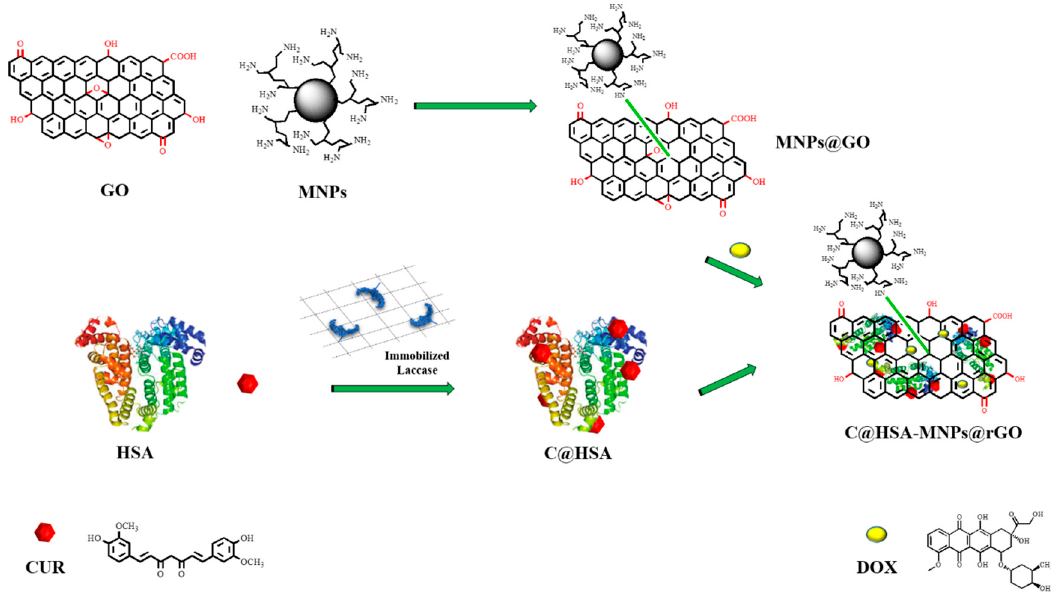
Figure 1. Schematic representation of the synthesis of nanohybrid C@HSA-MNPs@rGO.